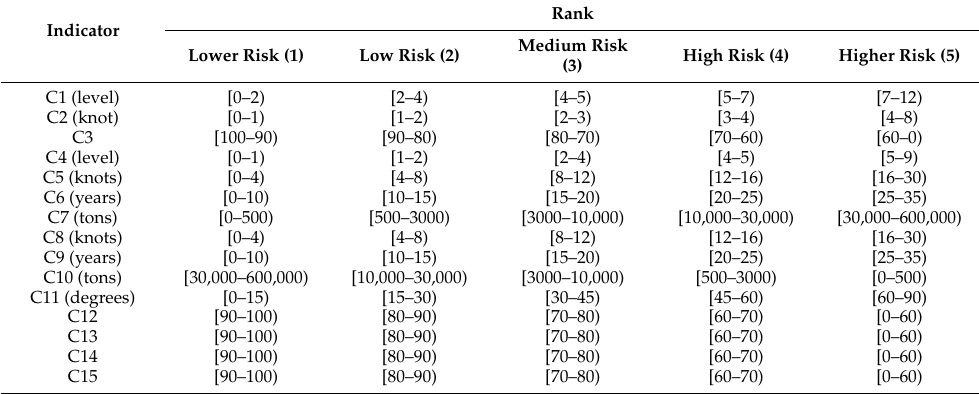
Table 1. Evaluation standards corresponding to each level of the emergency situation after collisions at